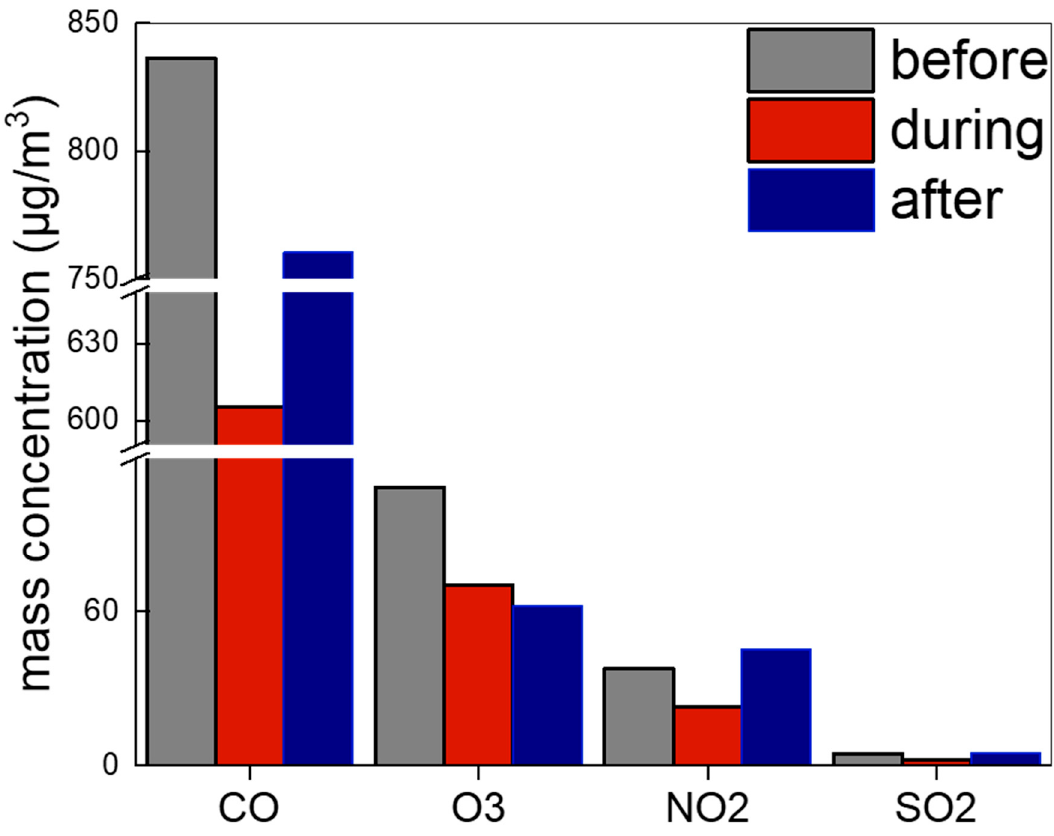
Figure 3. The column plots for other atmospheric chemical compound concentration in three periods (CO, O 3 , NO 2 , SO 2 ).